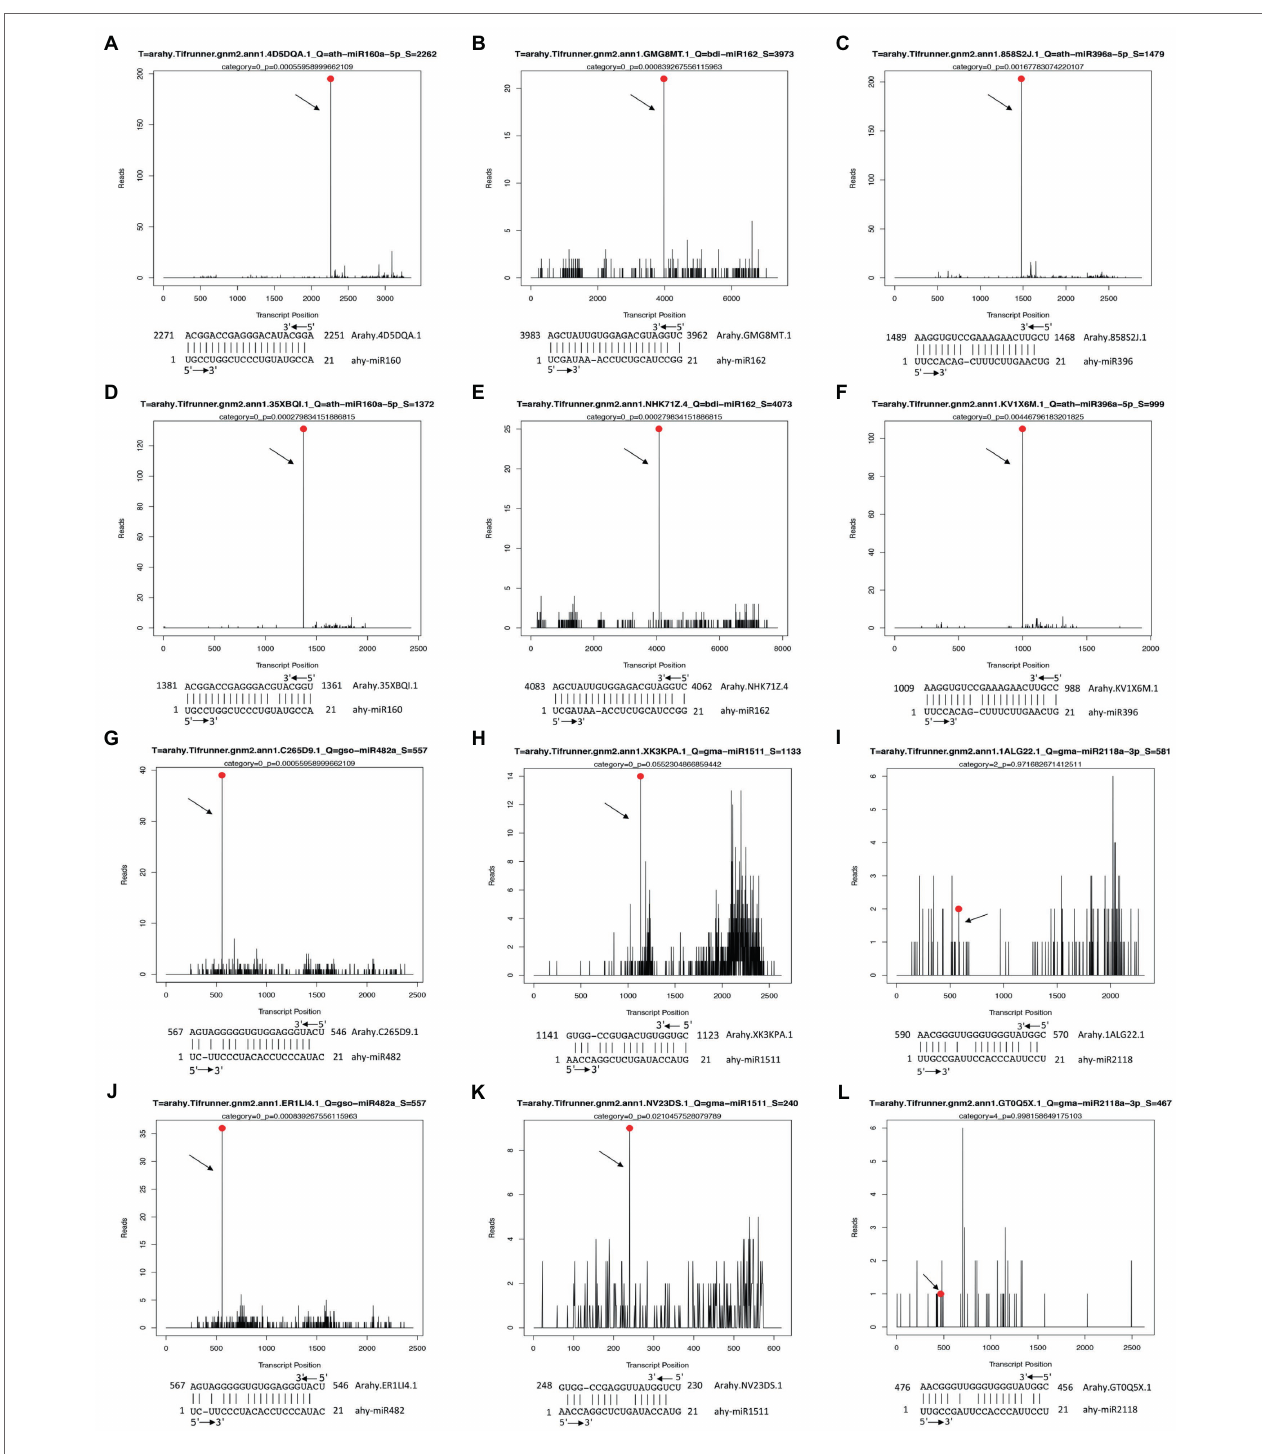
FIGURE 4 | Examples of T-plots of miRNA targets in two peanut RILs confirmed by degradome sequencing. The T-plots show the distribution of the degradome tags along the full length of the target mRNA sequence. The vertical red line indicates the cleavage site of each transcript and is also shown by an arrow. (A,D) The cleavage features in AhARF10 (Arahy.4D5DQA.1) and ARF17 (Arahy.35XBQI.1) mRNA by ahy-miR160 in DS1. (B,E) The cleavage features in AhDCL6 (Arahy. GMG8MT.1) and AhDCL16 (Arahy.NHK71Z.4) mRNA by ahy-miR162 in DS1. (C,F) The cleavage features in AhGRF1 (Arahy.858S2J.1) and AhGRF4 (Arahy. KV1X6M.1) mRNA by ahy-miR396 in DS1. (G,J) The cleavage features in AhWDRL1 (Arahy.C265D9.1) and AhWDRL2 (Arahy.ER1LI4.1) mRNA by ahy-miR482 in DS1. (H,K) The cleavage features in AhSRF (Arahy.XK3KPA.1) and AhSP1L1 (Arahy.NV23DS.1) mRNA by ahy-miR1511 in DS1. (I,L) The cleavage features in AhDR1 (Arahy.1ALG22.1) and AhDR2 (Arahy.GT0Q5X.1) mRNA by ahy-miR2118 in